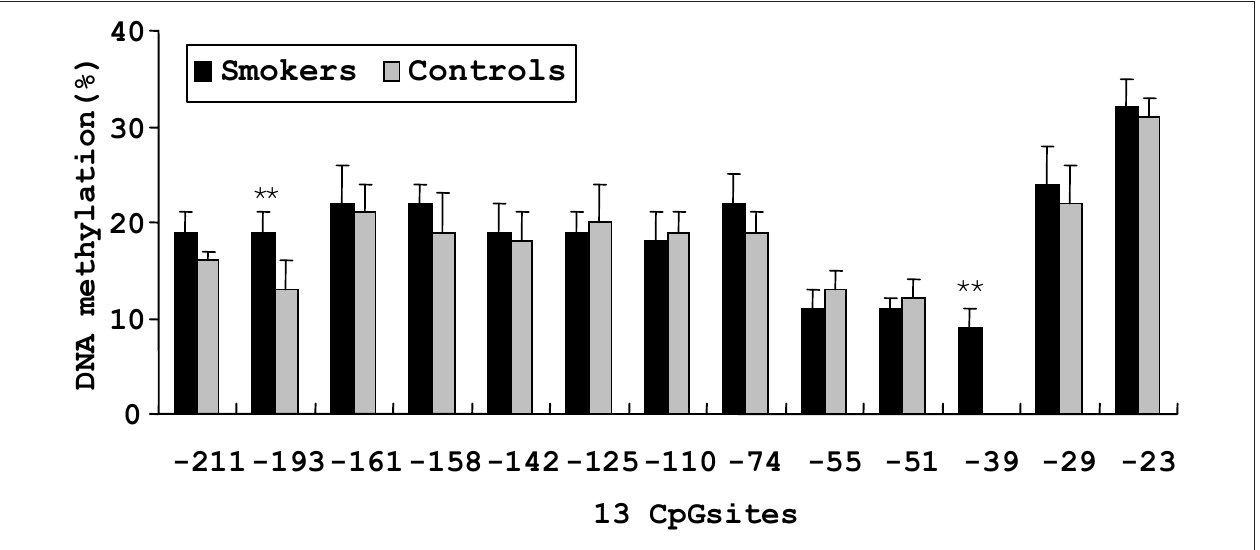
FiGure 2 | Percent methylation of 13 CpG sites by bisulfite sequencing in the promoter region of MB-COMT in smoker and non-smoker control samples. ** P < 0.01. Error bar represents SEM.